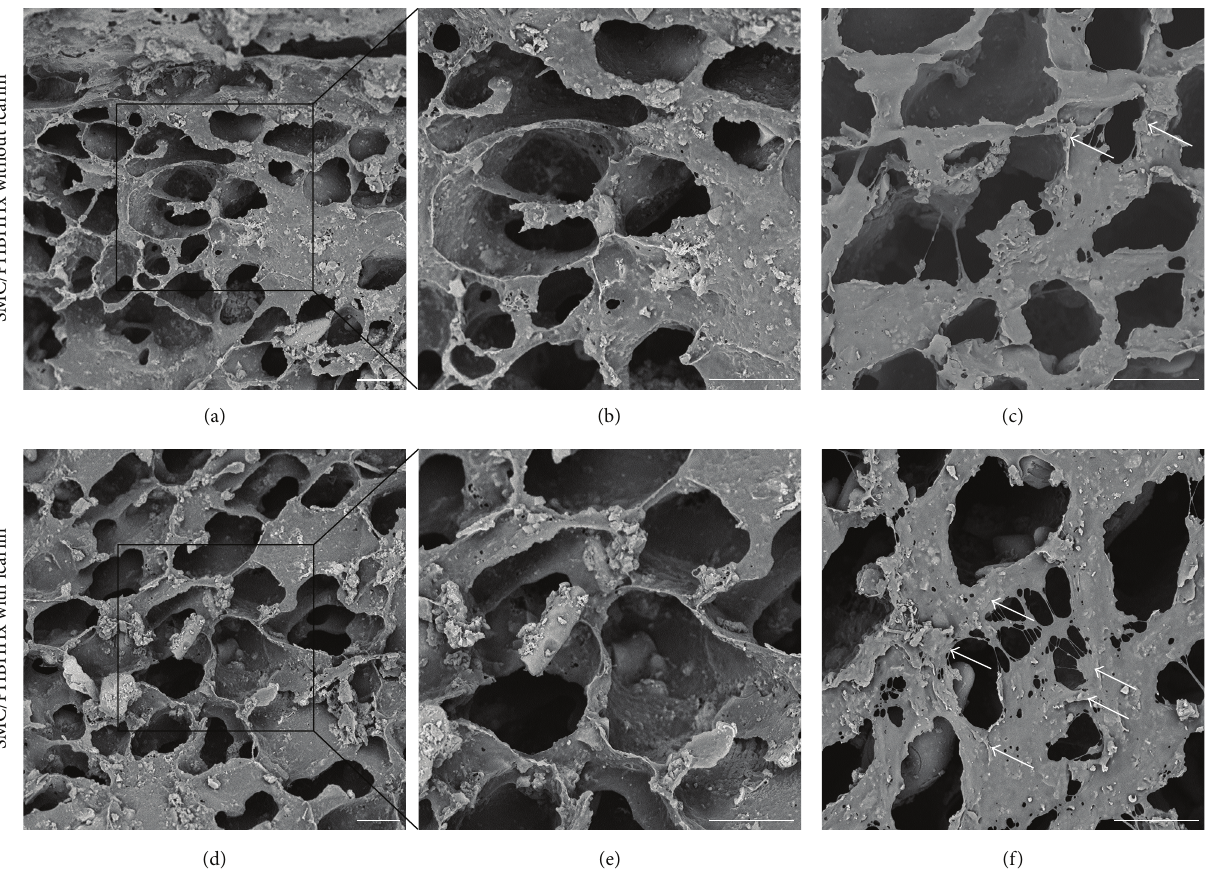
Figure 6: Scanning electron microscopy graphs depicting the morphology and topography of SMC-PHBHHx scaffolds without (a, b, d, e) or with (c, f) BMSCs in the absence (a, b, c) or presence (c, d, e) of 10 −6 mol/L icariin. Bar = 30 𝜇 m.